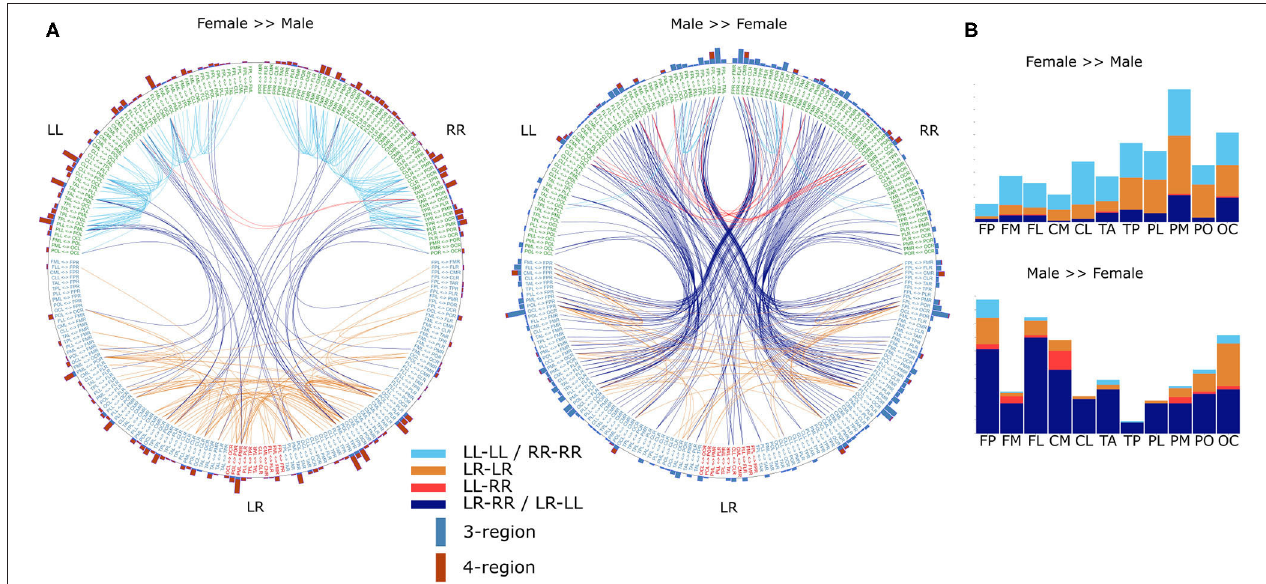
FIGURE 4 | Gender differences in the α frequency band. (A) DFC coefficients typically stronger in female brains (left) or male brains (right). For visualization, both sets represent the top 99 percentile of DFC coefficients for which the gender difference is largest. Text on the circle represent all 231 functional connections and we made a distinction between unilateral (LL and RR) and bilateral (LR) connections. Except for connections between cross-hemisphere homologs (LR), connections are ordered such that the left and right half are mirror images. Each line represents a DFC coefficient and its color distinguishes between the 4 lateralization based categories. Additionally, on the outer circle we used a bar for each connection to summarize in how many DFC coefficients it was involved. Furthermore, each bar is divided in a blue and a red part indicating the number of 3-region and 4-region DFC coefficients, respectively. (B) In the barplots the same data is plotted as the incidence of scalp regions in the set of DFC coefficients, averaged over both hemispheres. L, left hemisphere; R, right hemisphere; FP, fronto-polar; FM, frontal-mid; FL, frontal lateral; CM, central mid; CL, central lateral; TA, temporal anterior; TP, temporal posterior; PL, parietal lateral; PM, parietal mid; PO, parietal occipital; OC, occipital.